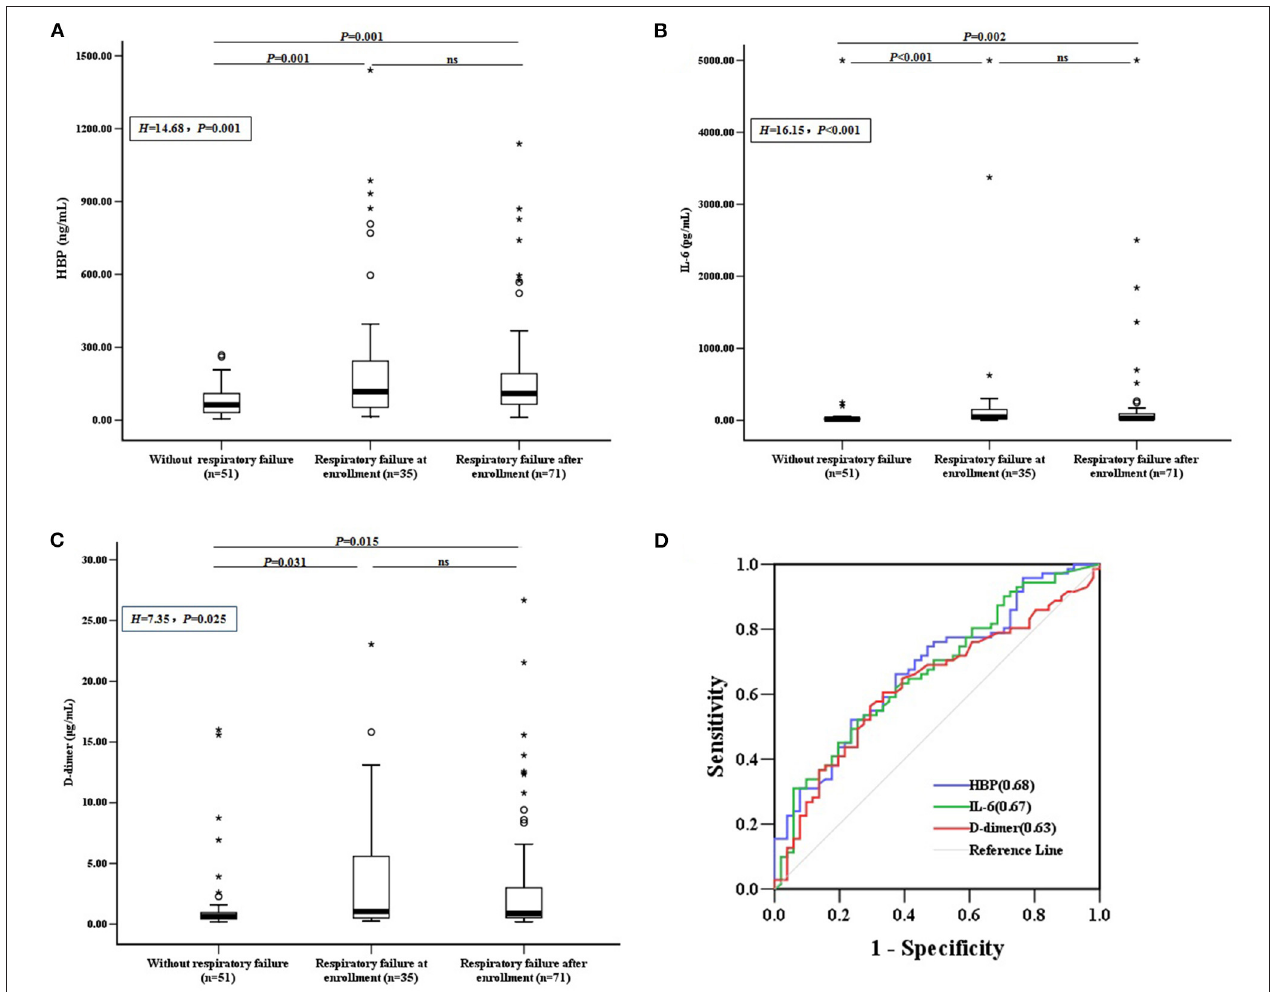
FIGURE 2 | Biomarkers and the development of RF. (A) HBP, (B) IL-6, and (C) D-dimer levels were compared between CAP children with RF at enrollment, with RF after enrollment, and without RF. Differences between these groups were analyzed using the Kruskal–Wallis H test, followed by rank transformation of the least-significant difference test. (D) ROC curves for biomarkers predicting the development of RF in children without RF at enrollment ( n = 122), and AUCs are indicated on the graph. AUC, area under the receiver operating characteristic curve; HBP, heparin-binding protein; IL-6, interleukin-6; ns, not significant; ROC, receiver operating characteristic; RF, respiratory failure; ◦ outlier;